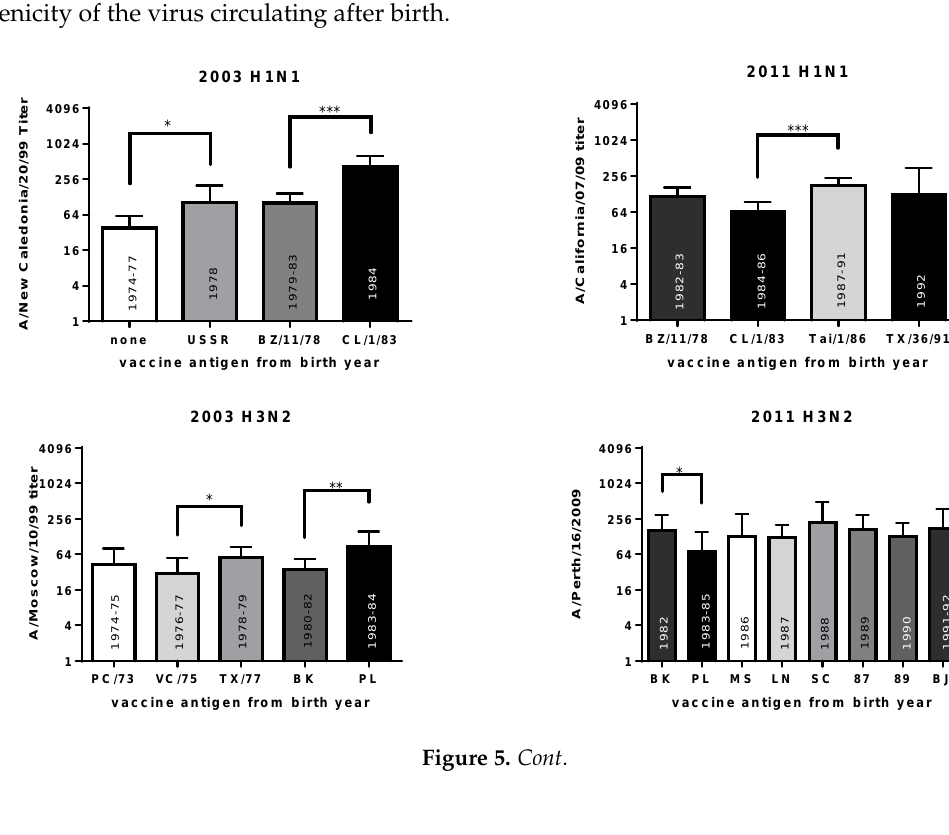
Figure 5. The geometric mean titers (with confidence interval) towards the vaccine antigens for the 2003 and 2011 cohorts based on antigens circulating after the year of birth. The year the antigens were recommended as vaccine strains are indicated inside the bars. The difference between sequential groups, born when different viruses circulated, was evaluated using the Mann Whitney rank test. *, p < 0.05; **, p < 0.01; and ***, p < 0.001. The viruses used for HI titer are A/New Caledonia/20/1999 (H1N1), A/Moscow/10/1999 (H3N2), and B/Hong Kong/330/2001 (Victoria lineage) for the 2003 cohort. The viruses used for testing HI titer are A/California/07/2009 (pdmH1N1), A/Perth/16/2009 (H3N2), and B/Brisbane/60/2008 (Victoria lineage) for the 2011 cohort. The H1N1 strains from the birth year are USSR (A/USSR/90/1977), BZ/11/78 (A/Brazil/11/1978), CL/1/83 (A/Chile/1/1983), Tai/1/86 (A/Taiwan/1/1986) and TX/36/91 (A/Texas/36/1986). The H3N2 strains from the birth year are PC/1/73 (A/Port Chalmers/1/1973), VC/3/75 (A/Victoria/2/1975), TX/1/77 (A/Texas/1/1977), BK (A/Bangkok/1/1979),